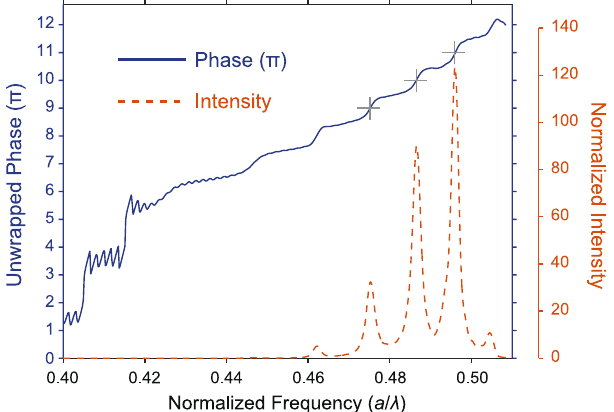
Figure 4. Accumulated phase and intensity enhancement relation. Superimposed phase and normalized intensity spectrum. The unwrapped phases are calculated with respect to the phase at the entrance of the structure. The gray cross markers indicate the locations of the intensity